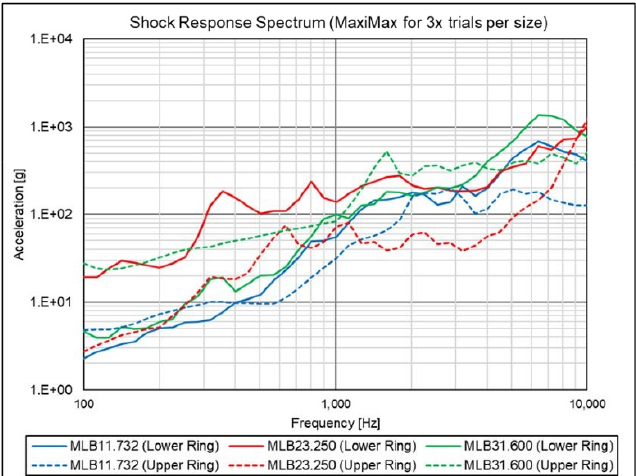
Figure 4. Lightband II shock response spectrum loading values [48].